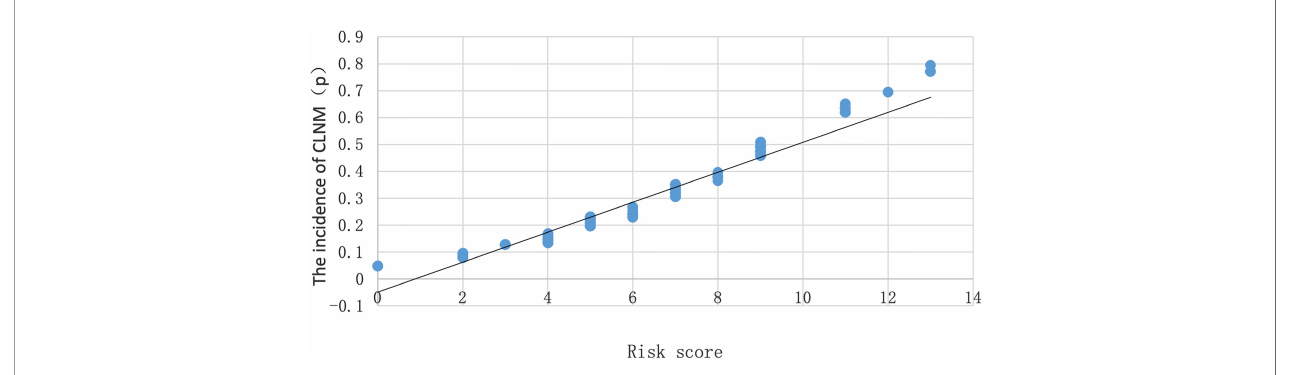
FIGURE 1 | Scatter plot of the relationship between the probability of occurrence (P) and risk score of